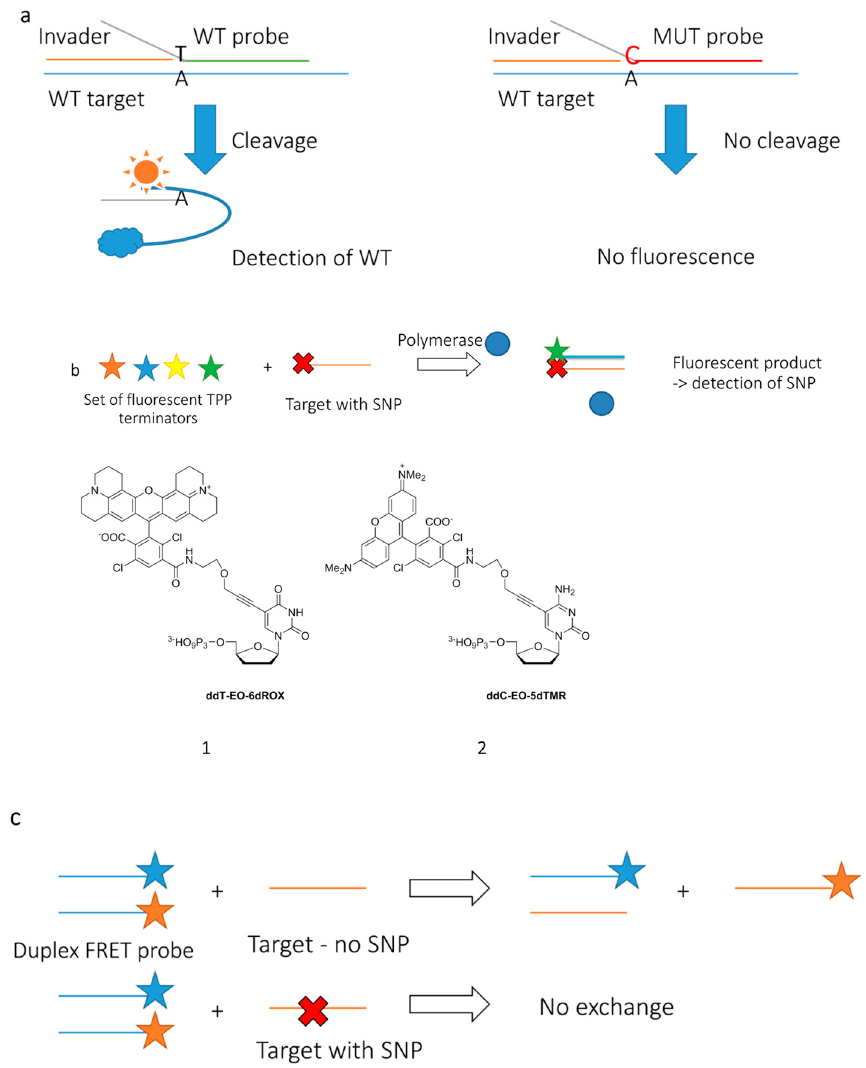
Figure 3. Mismatch sensitive FRET probe designs [61–65]: Invader probes ( a ), fluorescently labelled triphosphate terminators ( b ) and duplex probes ( c ). WT = wild type; MUT = mutant.